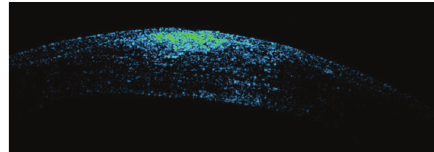
Figure 5: Anterior SOCT epithelium nonlinearity.